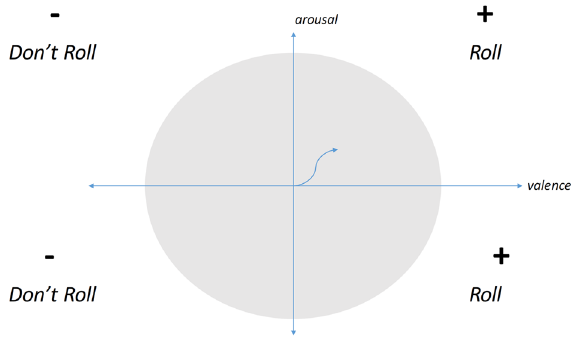
Figure 5. Decision Rule of the